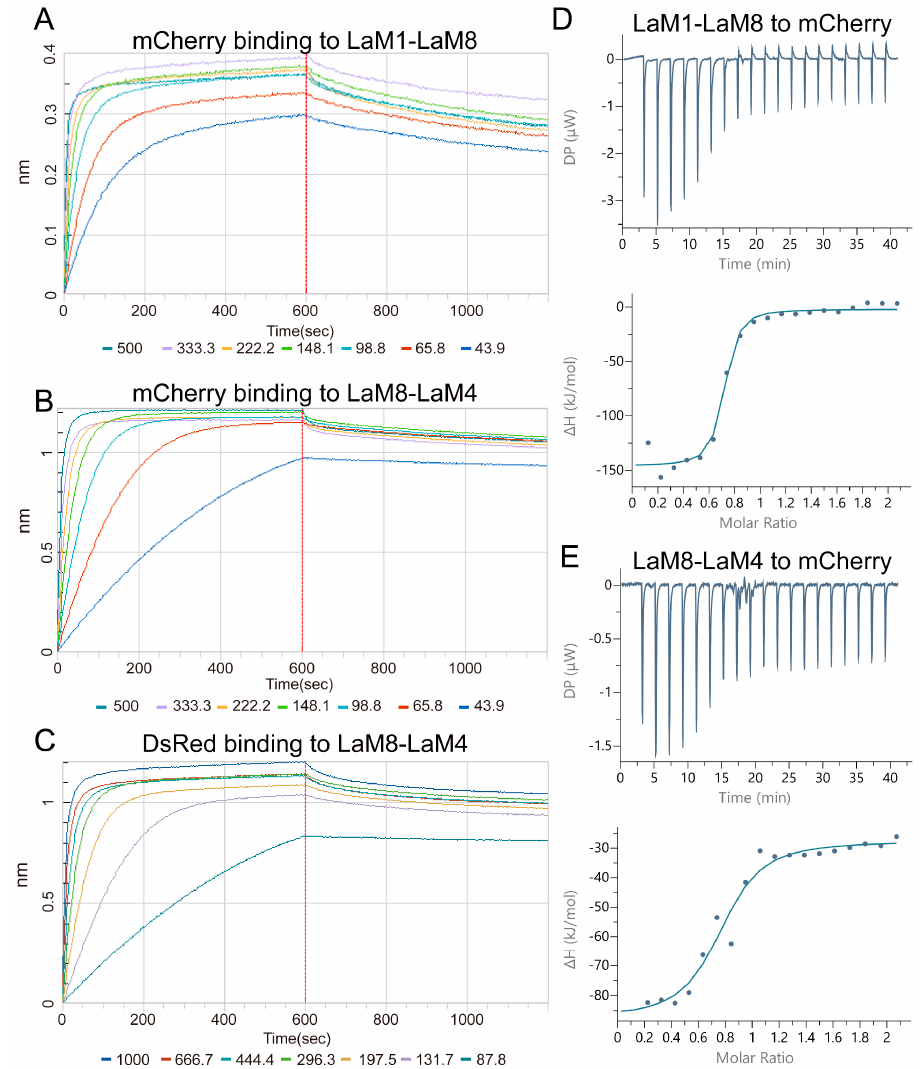
Figure 5. The binding kinetics and thermodynamics of multivalent LaM nanobodies to red fluorescent proteins ( A – C ) Binding kinetics of mCherry or DsRed with tandem LaMs by BLI. His − Sumo − LaM1 − LaM8 and His − Sumo − LaM8 − LaM4 proteins were loaded onto Ni − NTA biosensors, then equilibrated before setting the baseline to zero at t = 0, and the association within mCherry or DsRed is in the range of 0–600 s. The dissociation in kinetics buffer is in the range of 600–1200 s. The fitting model is 2:1 (heterogeneous ligand). The x − axis represents time, and the y − axis represents the amount of protein binding to the biosensor. ( A , B ) A total of 1000 nM His − SUMO − LaM1 − LaM8 and His − SUMO − LaM8 − LaM4 were loaded onto sensors, 500, 333.3, 222.2, 148.1, 96.8, 65.8, 43.9, and 0 nM mCherry were assayed for association and dissociation. ( C ) A total of 100 nM His − SUMO − LaM8 − LaM4 was loaded onto sensors, and 1000, 666.7, 444.4, 296.3, 197.5, 131.7, 87.8, and 0 nM DsRed were assayed for association and dissociation. ( D , E ) ITC of mCherry with tandem multivalent LaMs. Each subfigure shows raw data (upper) and a fitted curve (lower). Dots represent the acquired data in experiments, and lines represent the fitted curve. A total of 100 μ M LaM1 − LaM8 ( D ) or LaM8 − LaM4 ( E ) as syringe dropped into 10 μ M mCherry in the cell. The x − axis of the upper panels represents time, and the y − axis represents differential power (DP) between the sample cell and the reference cell. The x − axis of the lower panels represents the molar ratio, and the y − axis represents the molar change of calories in the syringe.